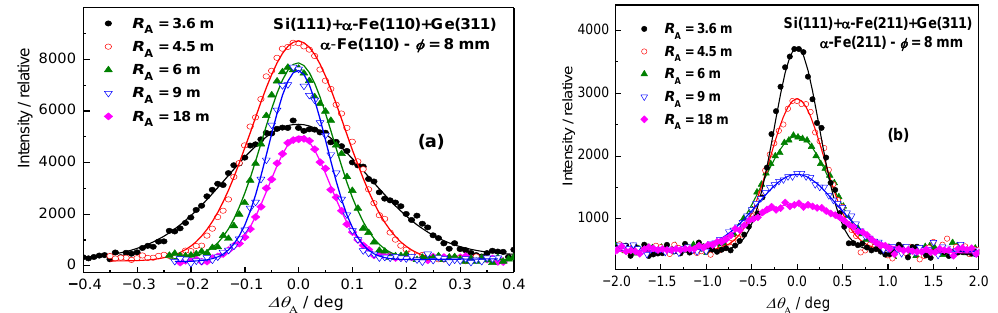
Figure 2. Three-axis diffractometer settings employing bent perfect crystal (BPC) monochromator and analyzer as used in the feasibility studies ( R M , R A —radii of curvature, θ M , θ A —Bragg angles) for vertical ( a ) and horizontal ( b ) positions of a polycrystalline sample. This figure has been reprinted from Ref. [7].